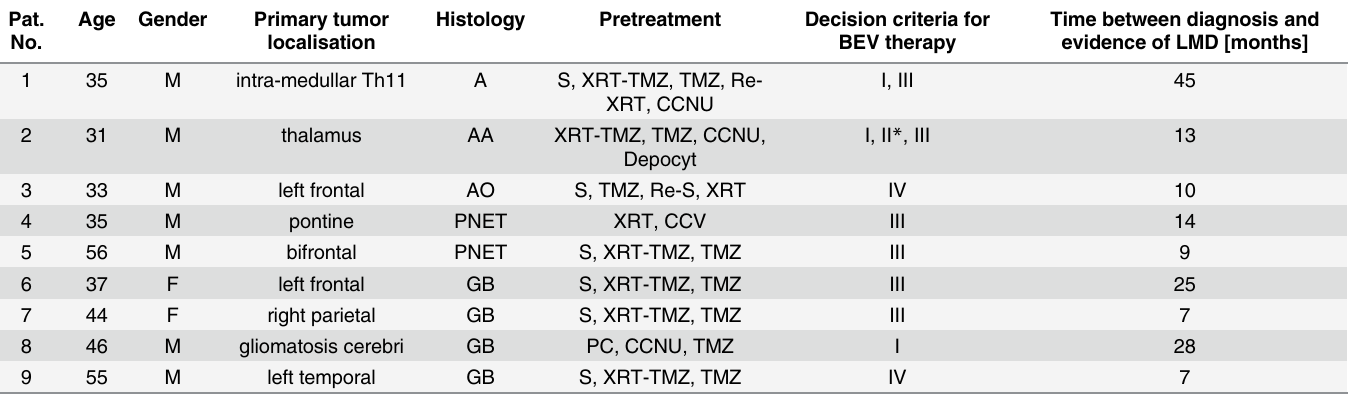
Table 1. Patient